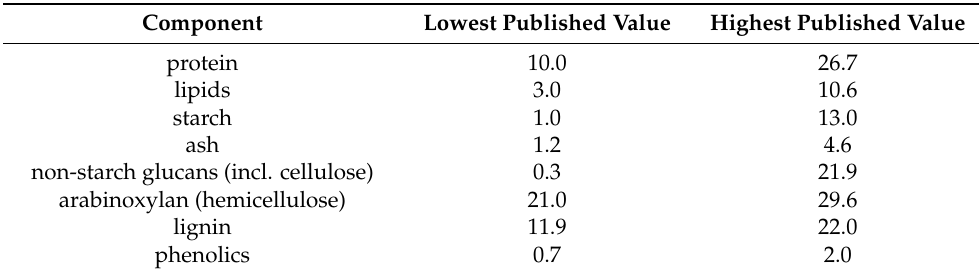
Table 1. Variability in composition of brewer’s spent grain. All values are expressed in g per 100 g dry matter (% w / w ). Table adapted from Xiros & Christakopoulos [13] using data reported by Kanauchi et al., 2001 [18], Santos et al., 2003 [19], Carvalheiro et al., 2004 [20], Mussatto & Roberto 2005 [21], Celus et al., 2006 [22], Jay et al., 2008 [23], Xiros et al., 2008 [24], and Robertson et al., 2010 [25]. Component Lowest Published Value Highest Published Value protein 10.0 26.7 lipids 3.0 10.6 starch 1.0 13.0 ash 1.2 4.6 non-starch glucans (incl. cellulose) 0.3 21.9 arabinoxylan (hemicellulose) 21.0 29.6 lignin 11.9 22.0 phenolics 0.7